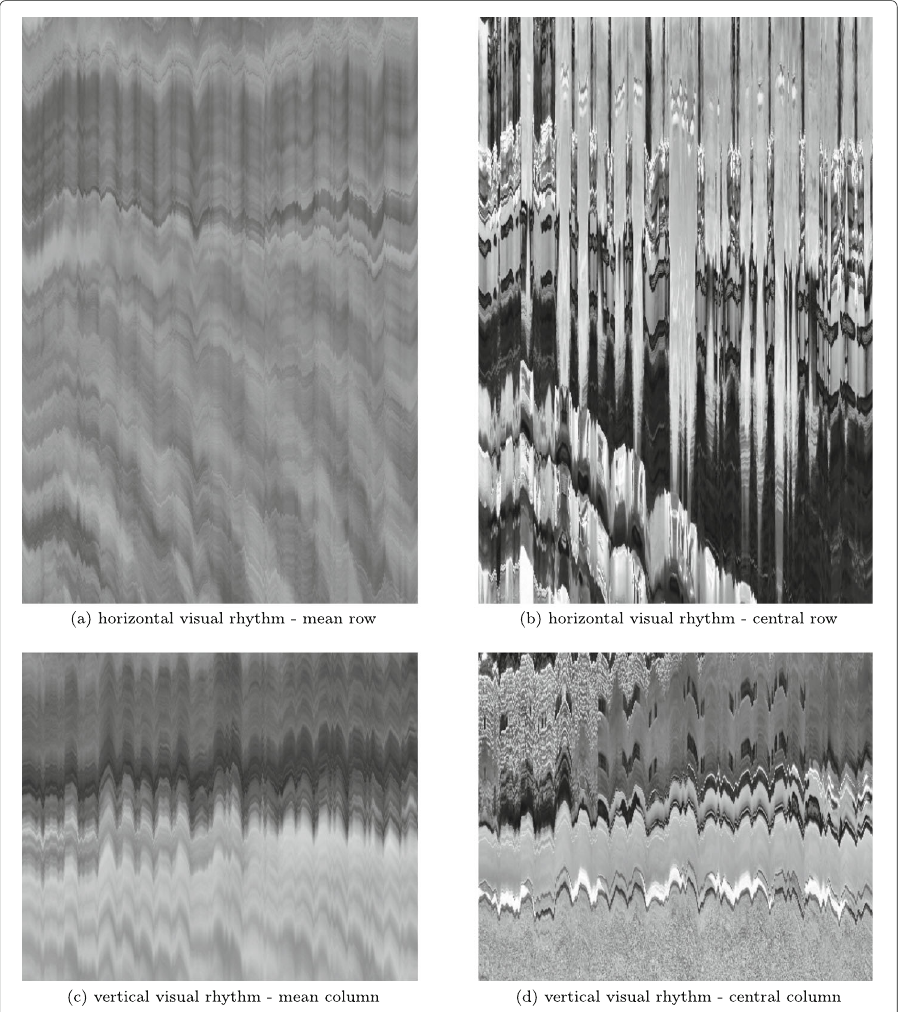
Fig. 11 Visual rhythms for original video Regular 8 . a Horizontal visual rhythm with mean row. b Horizontal visual rhythm with central row. c Vertical visual rhythm with mean column. d Vertical visual rhythm with central